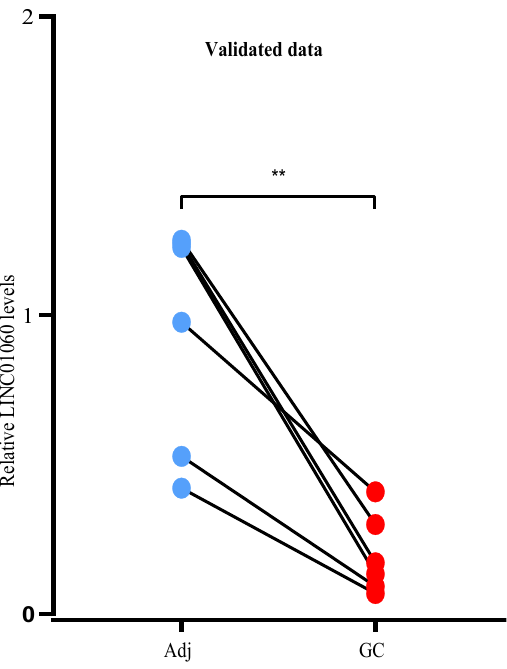
Figure 1: Expression levels of LINC01060 in gastric cancer tissues; LINC01060 expression in GC tissues compared to paired adjacent tissues in six patients.